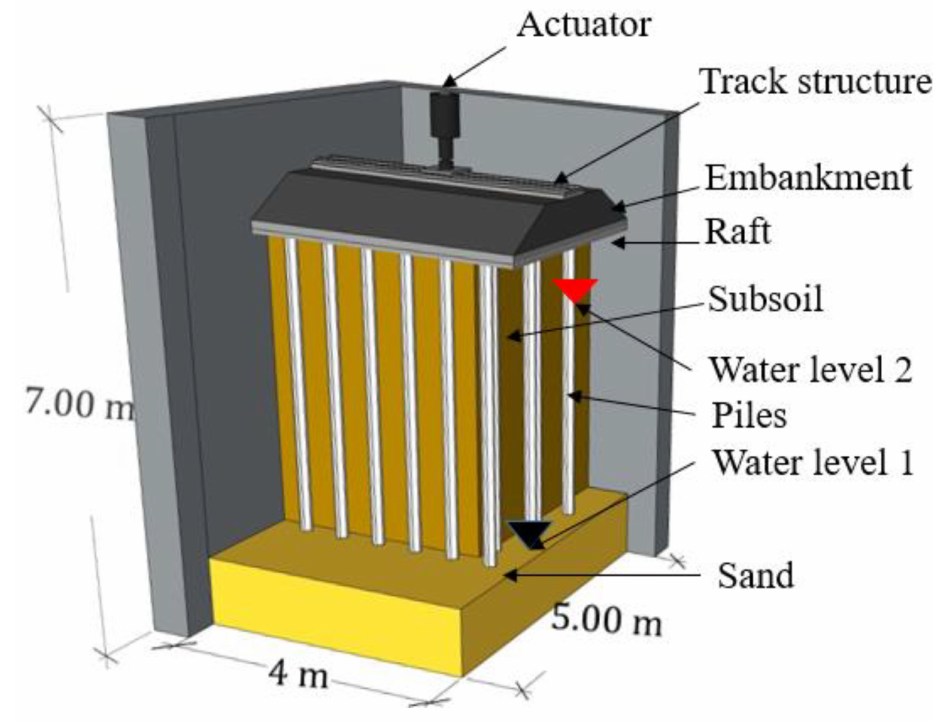
Figure 1. Geometric structure layout of track structure and piled raft